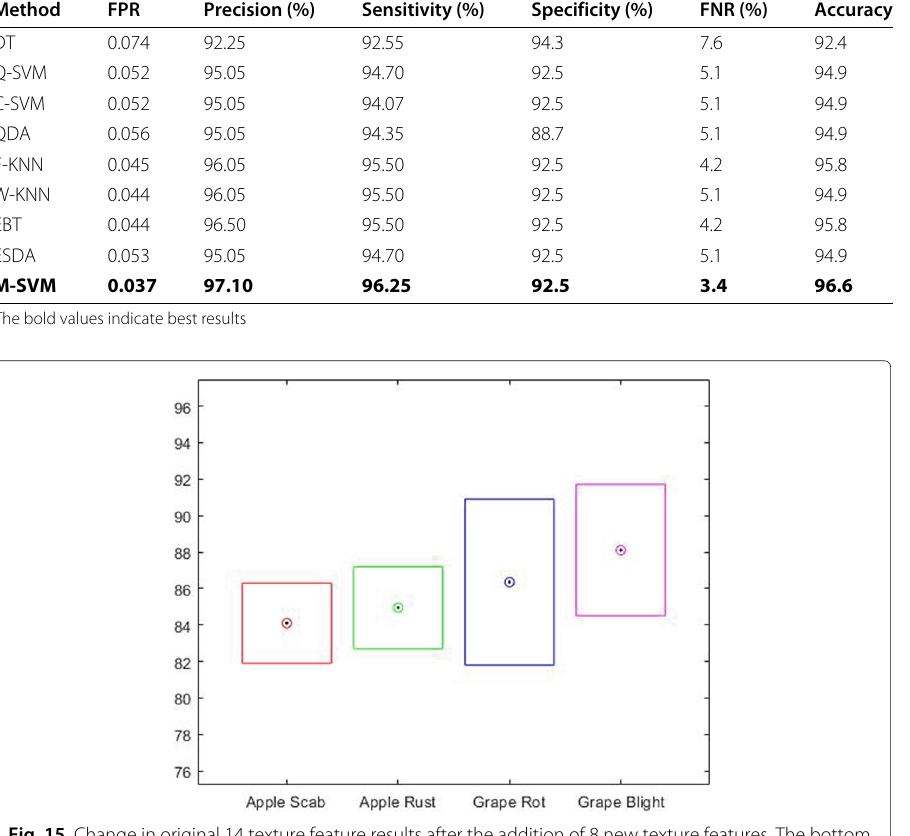
Fig. 15 Change in original 14 texture feature results after the addition of 8 new texture features. The bottom lines show the original features accuracy whereas the above lines present the accuracy after addition of 8 features. Moreover, the left side values of the plot indicates the accuracy values